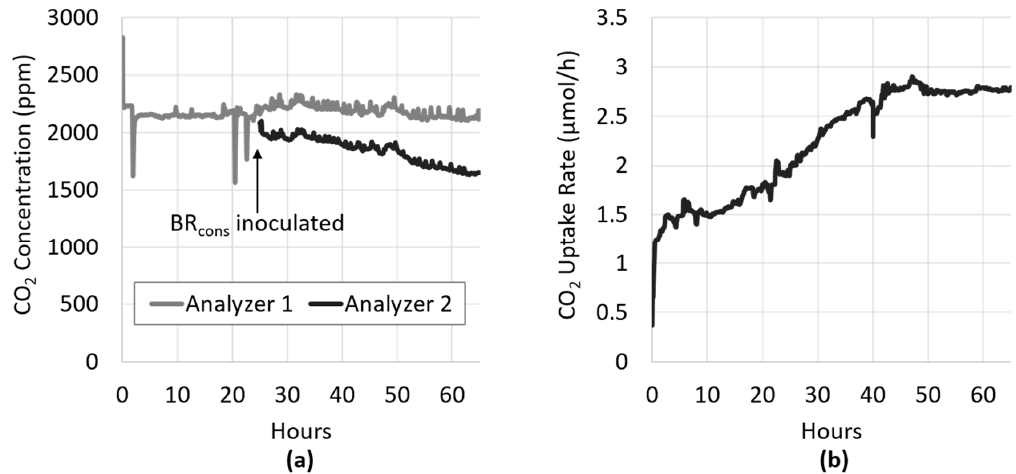
Figure 3. BR cons was inoculated with the photoautotrophic culture approximately 24 h after inoculation of the heterotrophic culture into BR1. ( a ) Divergence between BR cons influent and effluent CO 2 concentration (Analyzer 1 and 2, respectively) was apparent within several hours of inoculation. ( b ) Using the ideal gas law, the difference between the influent and effluent concentration was converted to the rate of CO 2 uptake, which resembled a typical microbial growth curve.